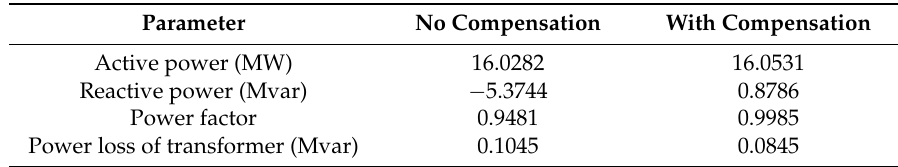
Table 3. Active power and reactive power at the public network side and power loss of new grid-connected